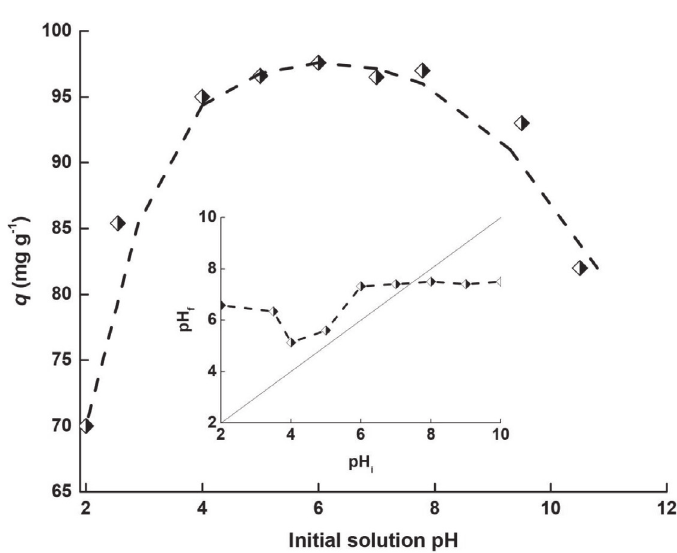
Fig. 5 – Effect of pH of solution on adsorption of humic acid (temperature 305 K, adsorbent dosage 25 mg, HA concentra- tion 50 ppm); (Inset graph presents the determination of PZC of Co-MOF (temperature = 305 K, adsorbent dosage = 25 mg))